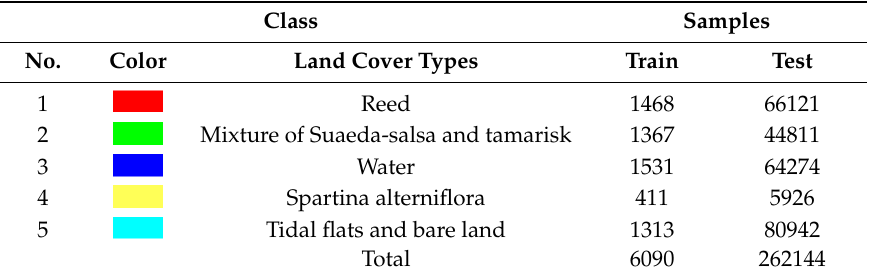
Figure 6. Training samples distribution. ( a ) False color image composite (band 15, 10 and 5); ( b ) ground truth of training samples. Table 4. Land cover classes and the number of training samples for Yellow River Mouth wetland data set.